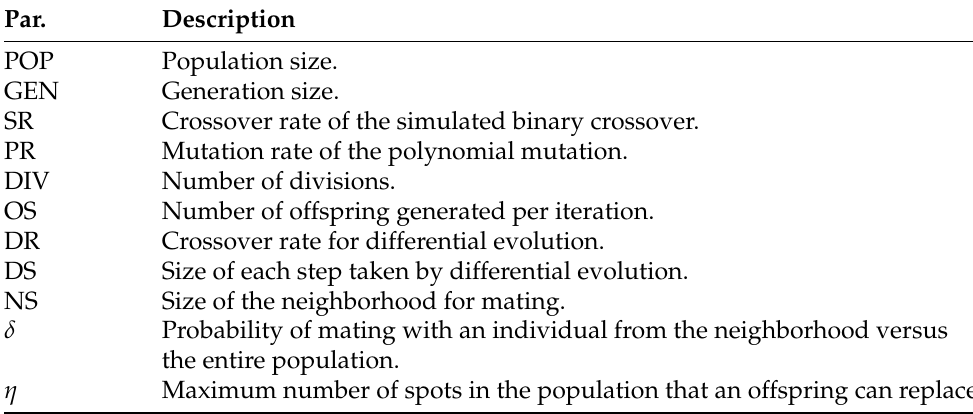
Table 2. Description of parameters shown in Table 1.